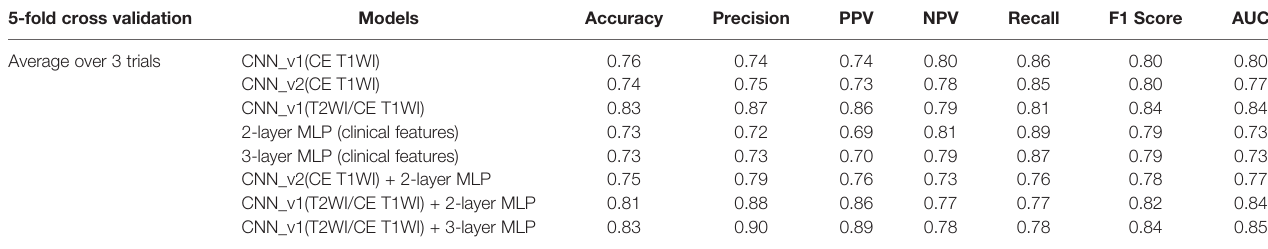
TABLE 2 | Performance of CNN, MLP, and multimodal CNN-MLP architectures for prediction of P/R in validation set of NFMAs. 5-fold cross validation Models